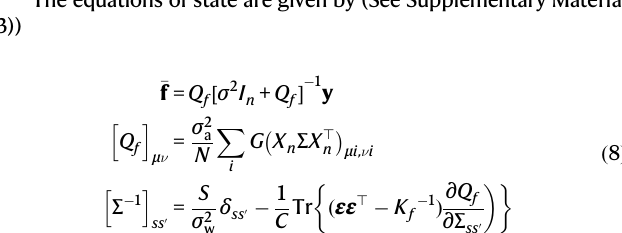
numerical solution of the equations of state, respectively. Train-set comparisons are shown in the inset. Right. Statistics of w ⋅ w * / ∣ w * ∣ of the trained CNN (blue) compared with w projected on a normalized random vector (green) for the n =1600 experiment with C =640. Dashed lines show fi t to a